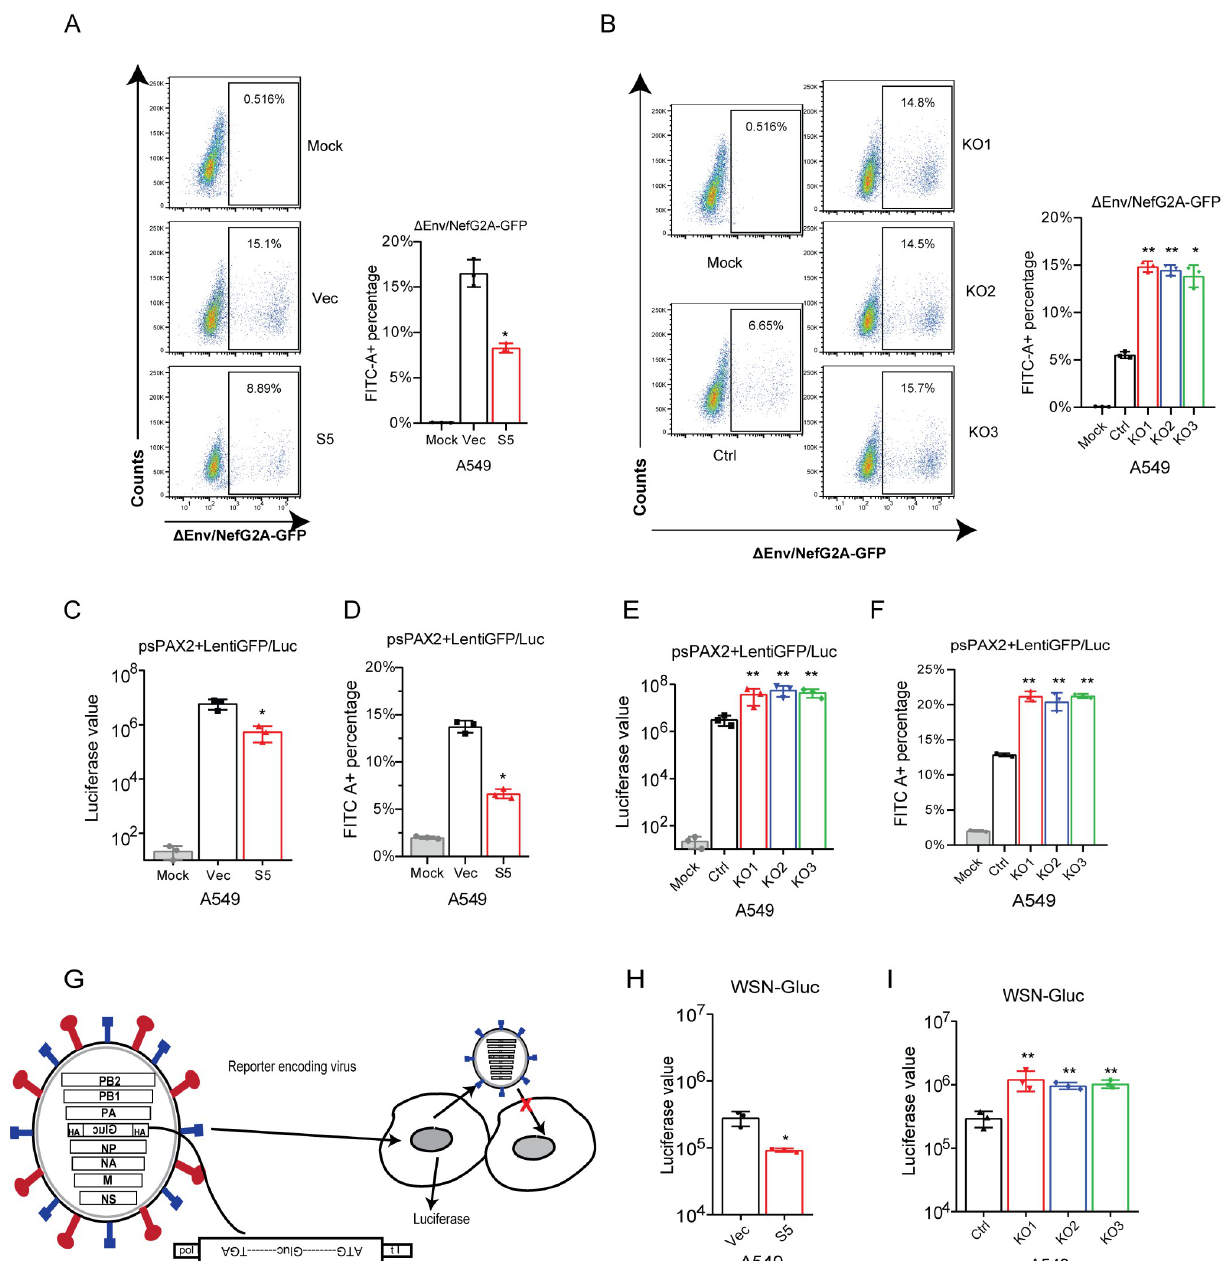
Fig 2. SERINC5 inhibits IAV infection when expressed in virus target cells. A-B: Pseudoviruses Δ Env/NefG2A-GFP HIV-1 NL4-3 bearing IAV HA/NA proteins were used to infect A549 SERINC5-overexpressing cells (20ng p24 antigen) or SERINC5-knockout cells (10ng p24 antigen). Virus infection was examined by scoring GFP-positive cells with flow cytometry. C-F: Pseudovirions psPAX2 with influenza HA/NA proteins infected A549 SERINC5-overexpressing cell (20ng p24 antigen) (C, D) and SERINC5-knockout cell (10ng p24 antigen) (E, F). Half of the A549 cells were lysed to measure luciferase activity (C, E), the other half of A549 cells were fixed to measure pseudovirus infectivity by flow cytometry. Percentages of FITC- positive cells are shown in the column (D, F). G: Illustration of IAV for single-round infection. The HA ORF was replaced by Gluc. HA protein was expressed from the plasmid DNA. The expression plasmid of HA and 7 plasmids encoding IAV genomes were co-transfected to obtain the single-round IAV which can infect cells and produce secreted Gluc, but does not express HA protein and does not produce infectious virus particles for the next round of infection. This IAV is competent for a single-round infection. H-I: The single-round IAV was used to infected A549 SERINC5-overexpressing cells (MOI = 0.05) (H) or SERINC5-knockout cells (MOI = 0.01) (I). Levels of Gluc in the culture supernatants were measured 8 h.p.i. Results shown are the averages of three independent experiments. Statistical significance was calculated by unpaired t -test. ns: not significant; � : P < 0.05; �� : P < 0.01.